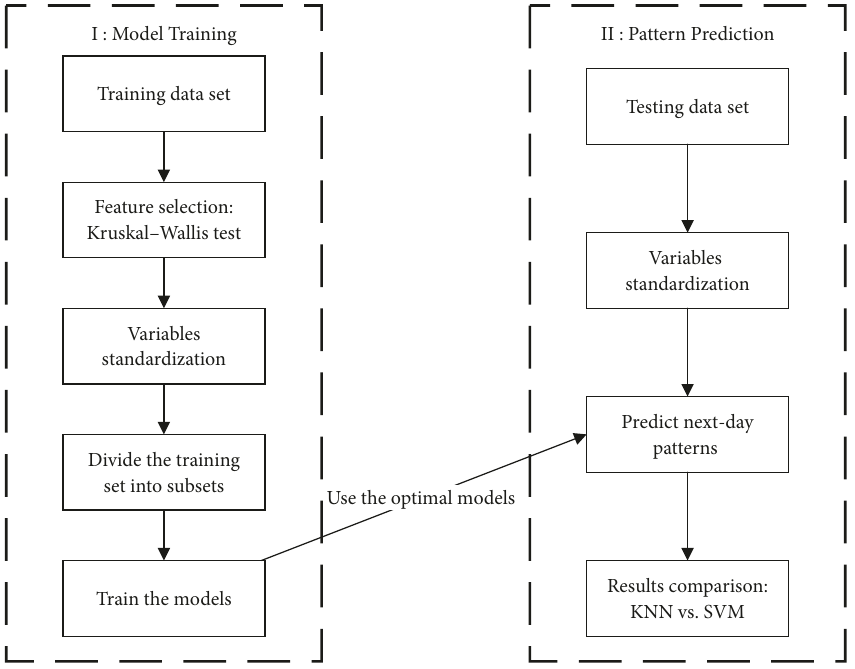
Figure 3: The road map of the pattern prediction